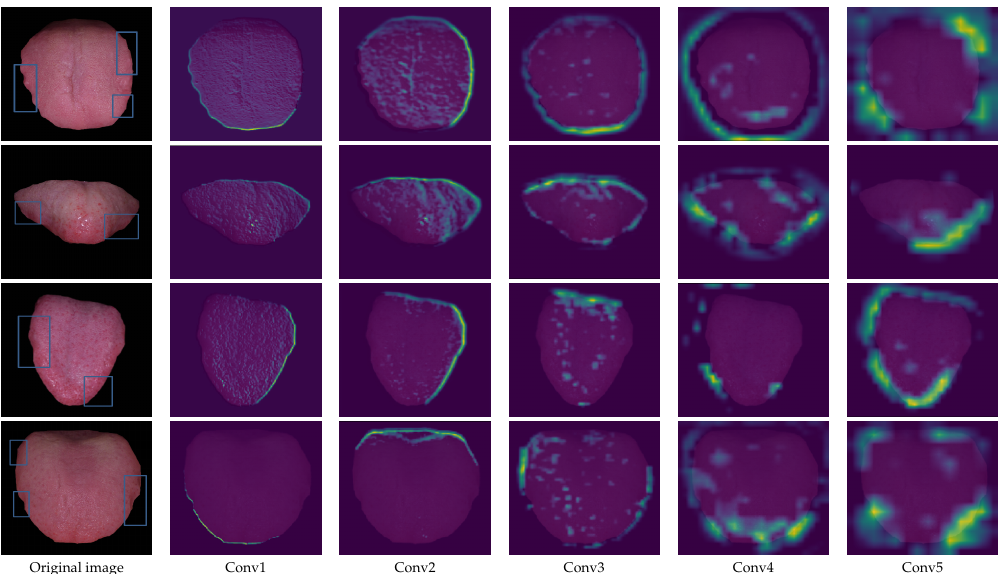
Figure 7. Grad-CAM localizations for the “tooth-marked tongue” category on different convolutional layer feature maps in our model. The first column is the original tongue image and teeth-marked regions are contained in blue boxes. The remaining columns of each row corresponds to